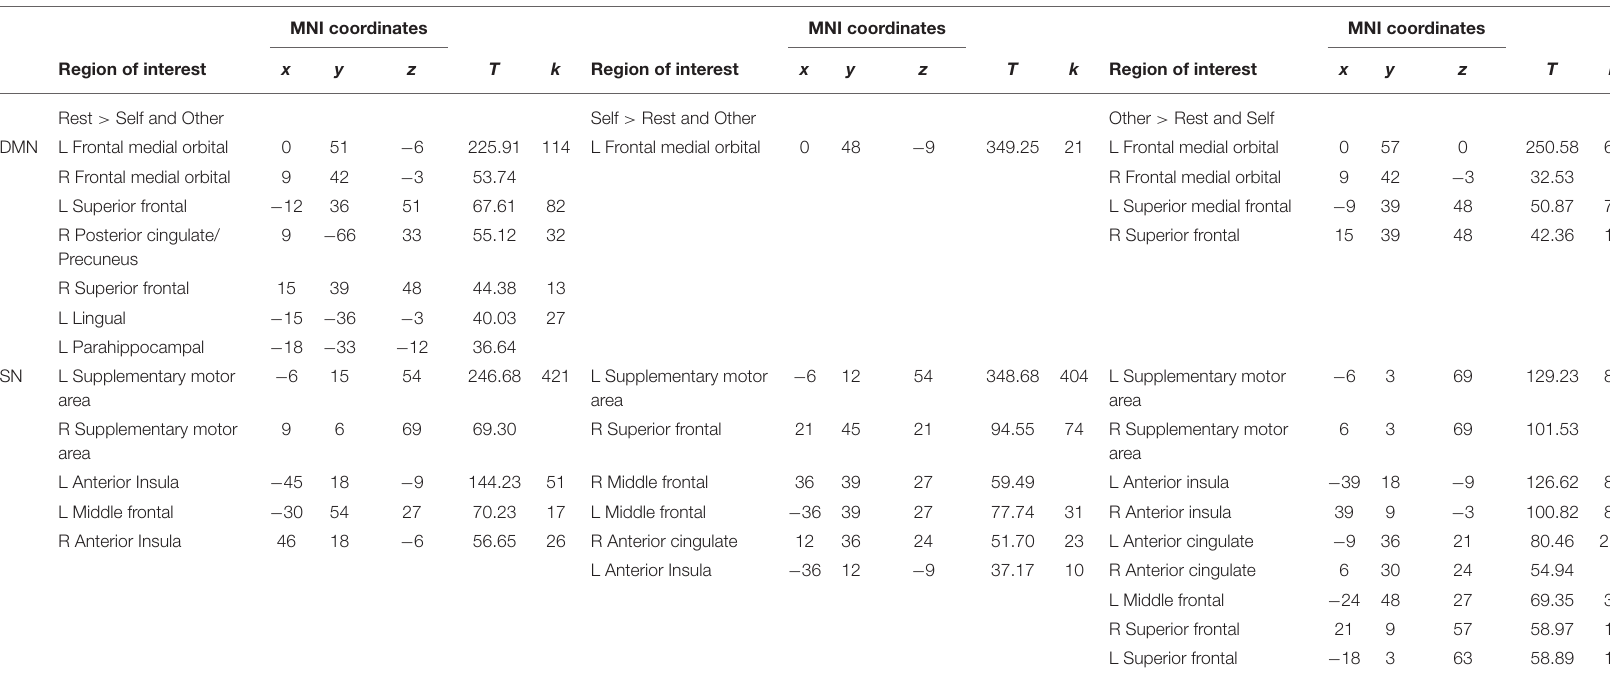
TABLE 2 | Condition dependent differences of the DMN and SN’s functional